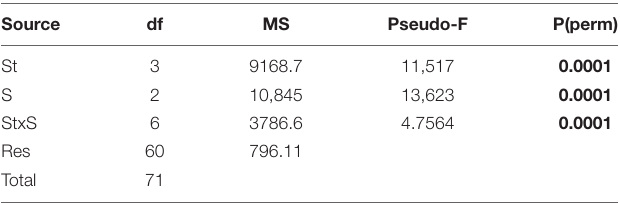
TABLE 6 | Results from one-way ANOVA test (treatment vs. control) on the number of taxa of hard substrates under the cages. Source SS